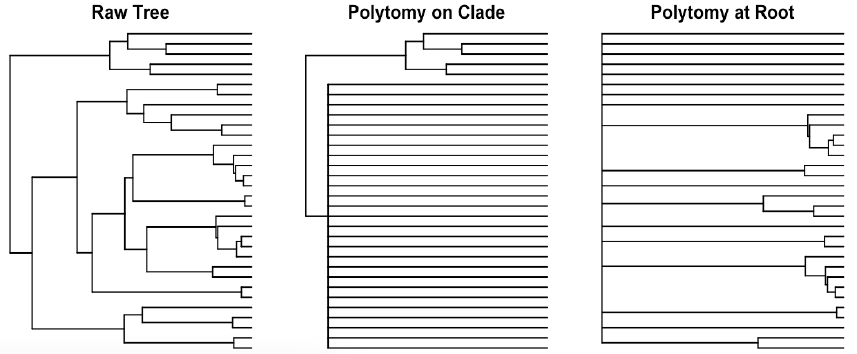
Figure 6. Trees with severe polytomy. Left panel : a pure birth tree. Middle panel : polytomy on a clade. Right panel : polytomies on the